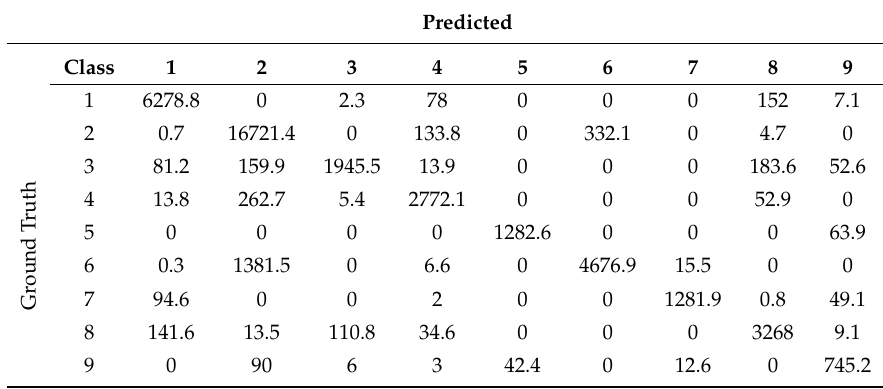
Table 5. The confusion matrix of the proposed SPFS-SRC from the PaviaU dataset corresponding to Table 3.